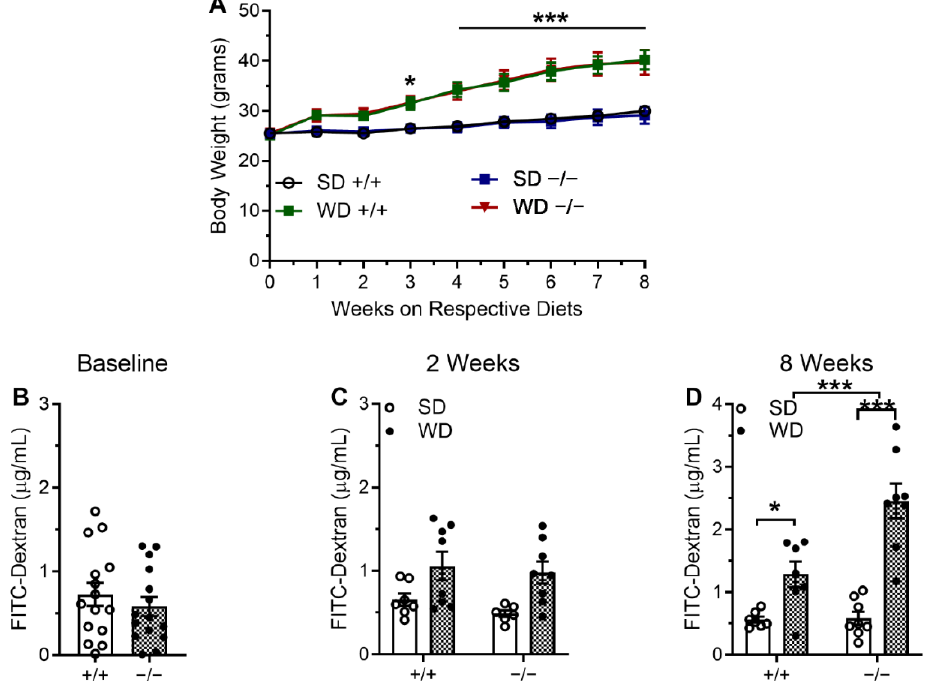
Figure 3. Large-intestinal permeability is increased in mice fed WD and further exacerbated in intCB1R −/− mice fed WD. Independent of genotype, mice fed WD gained significantly more weight when compared to mice fed SD ( A ). intCB1R − / − mice displayed no changes in baseline paracellular permeability when compared to intCB1R+/+ control mice ( B ). Exposure to WD for two weeks did not induce significant changes in paracellular permeability in intCB1R+/+ control mice or intCB1R − / − mice ( C ). Exposure to WD for 8 weeks in intCB1R+/+ control mice, led to increases in large-intestinal paracellular permeability that was exacerbated in intCB1R − / − mice ( D ). Baseline FITC-Dextran data analyzed via unpaired two-tailed Student’s t -test. Body weight data analyzed via three-way ordinary ANOVA with effects of diet F(1, 252) = 211.3, p < 0.0001; time F(8, 252) = 24.42, p <